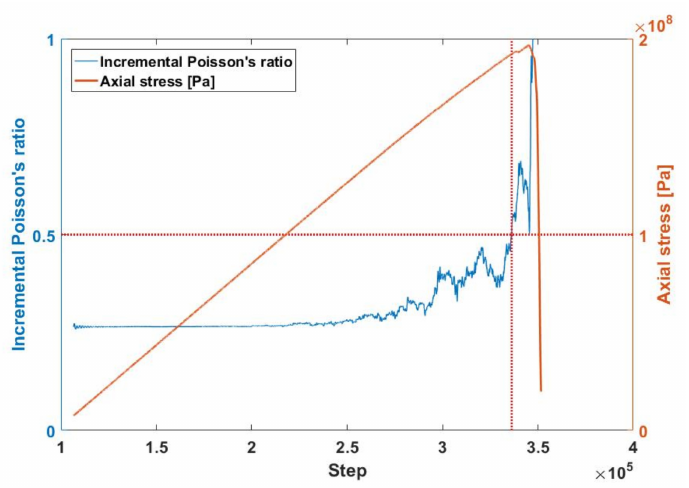
Figure 8. Incremental Poisson’s ratio and axial stress vs. time (in steps) in 3D